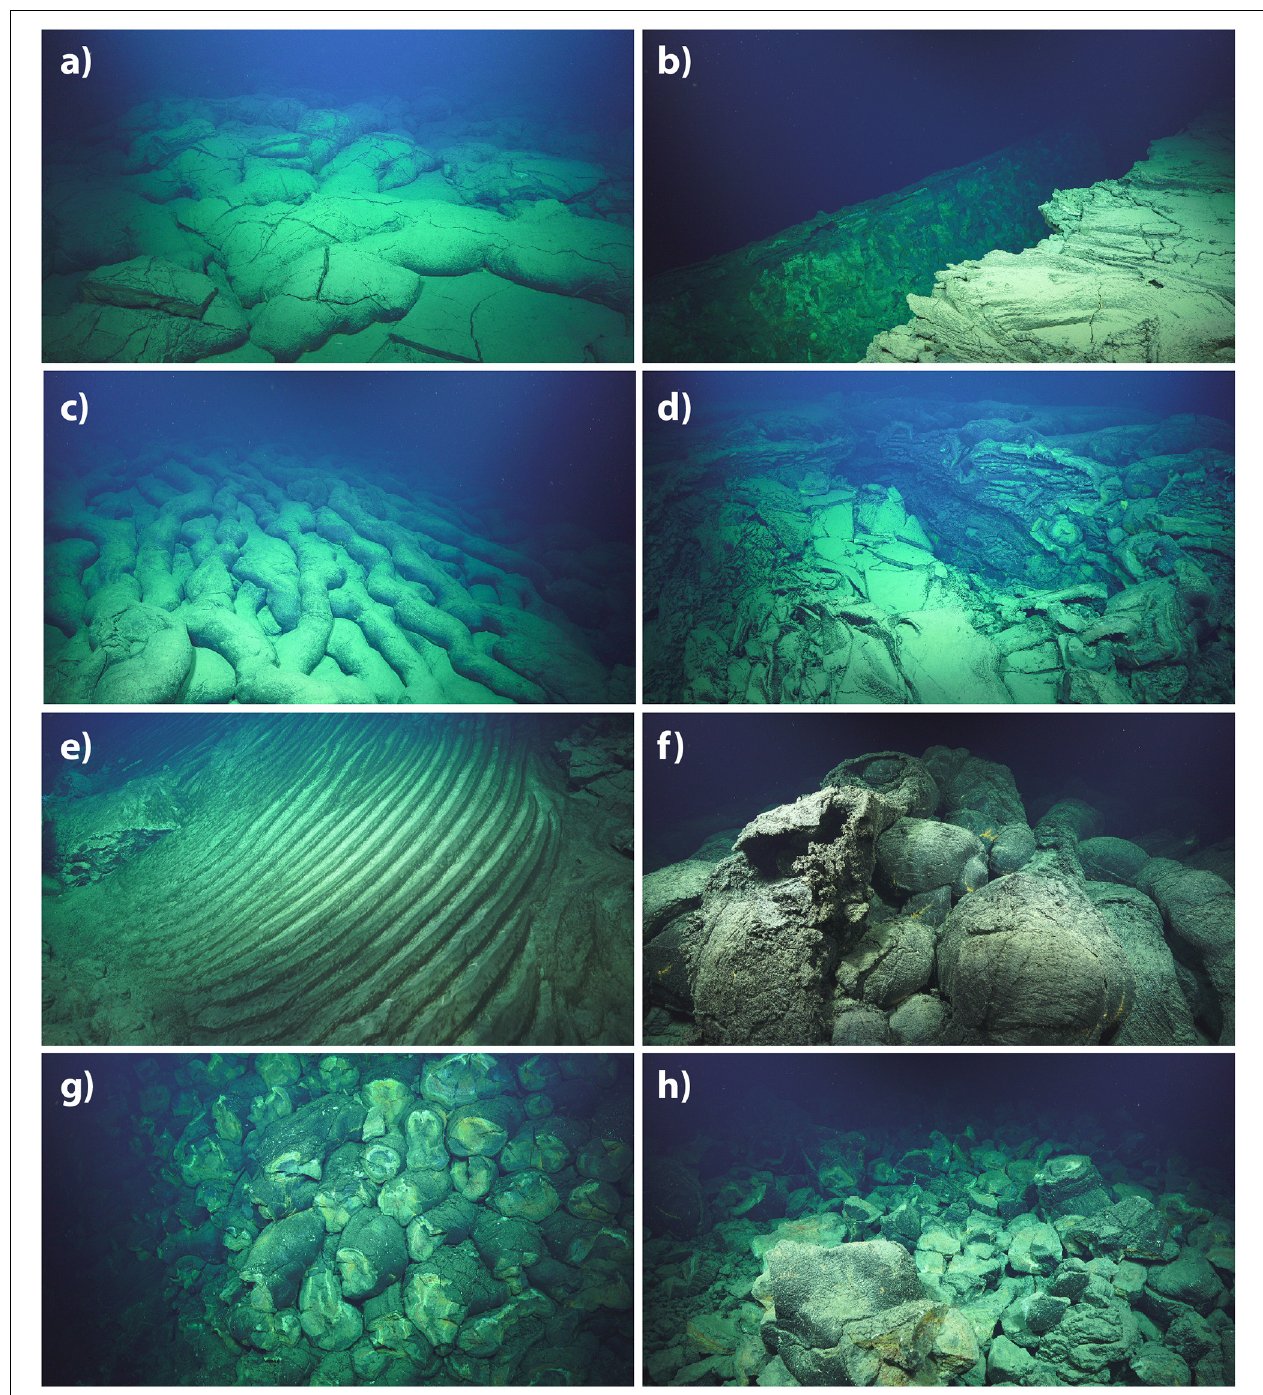
FIGURE 15 | Images of eruption sites #5 (2010–2011) and #6 (1996–2008) from ROV SuBastian dive S95. Numbers in parentheses are time of photo in GMT and horizontal scale. See Figure 14c for photo locations. (a) Broad lobes of 2010–2011 lava near northern flow margin (20:34:50, 5 m). (b) Uplifted sheet lava in tumulus structure near northern 2010–2011 flow margin (22:21:14, 5 m). (c) elongate pillows on north slope of 2010–2011 pillow ridge (23:14:48, 8 m). (d) Eruptive fissure with lava drain-out at crest of 2010–2011 pillow ridge (01:24:04, 8 m). (e) Volcaniclastic-rich sediment ripples at southern margin of 2010–2011 pillow ridge, oriented perpendicular to the downslope direction (00:05:08, 5 m). (f) Crest of 1996–2008 pillow lava mound with intact lavas (03:35:11, 3 m). (g) Landslide scarp of truncated 1996–2008 pillows on downslope edge of pillow mound (03:31:13, 5 m). (h) Pillow talus below landslide scarp in 1996–2008 lavas (02:39:27, 5 m).